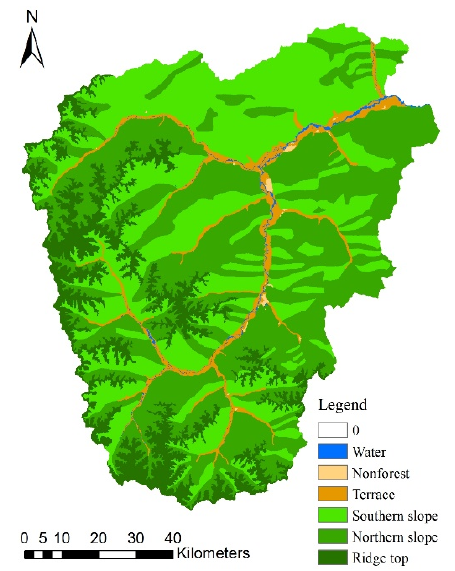
Figure 2. Land type map of the Huzhong Forestry Bureau.